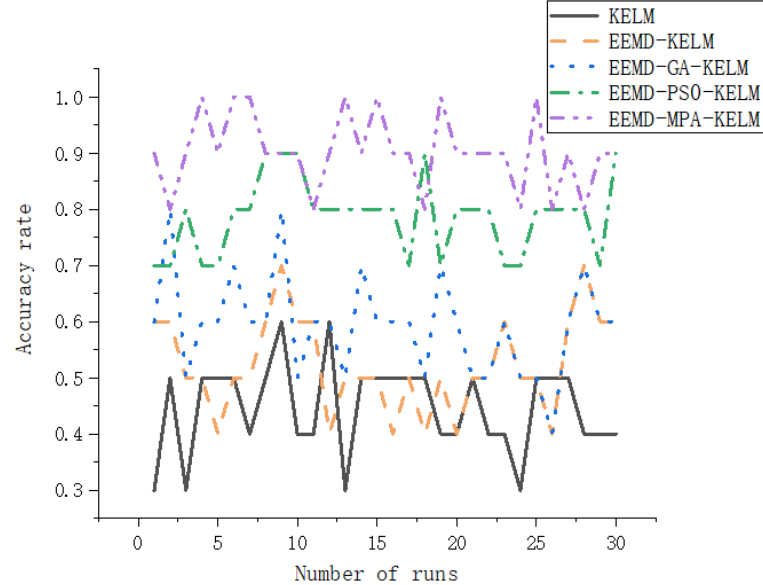
Figure 12. Comparison of accuracy of 30 runs of various models.